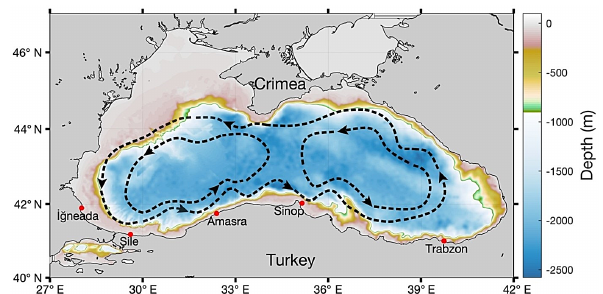
Figure 1. Locations of tide gauge stations and the bathymetry (m) of the Black Sea with an overlaid schematic of the circulation (after Korotaev et al.,